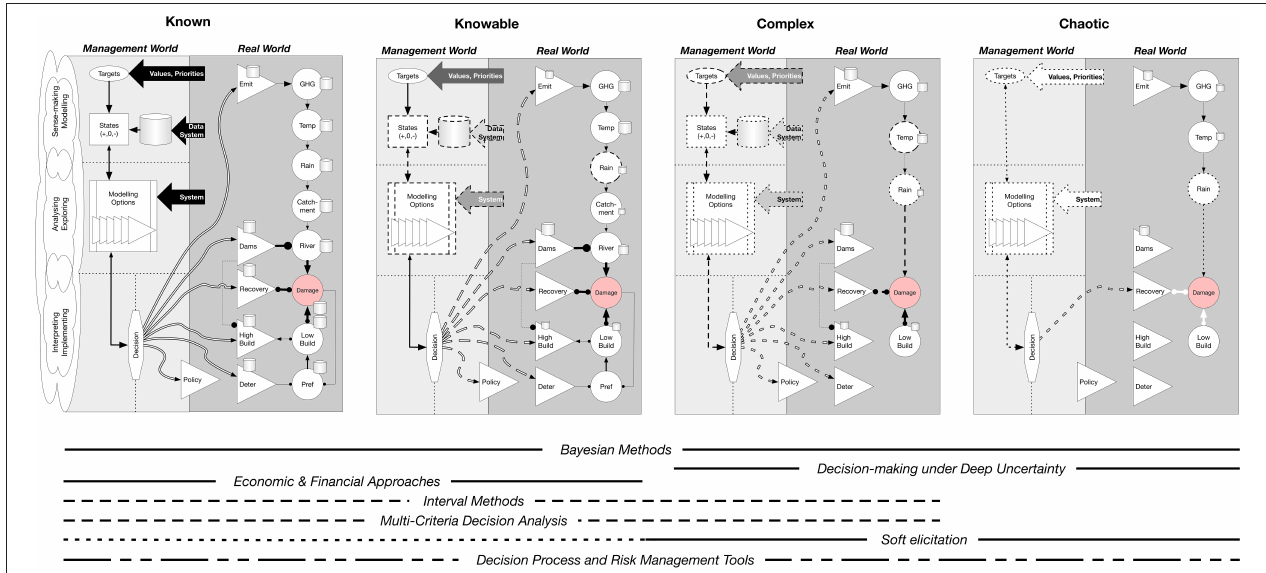
FIGURE 6 | Illustration of how a management system, including the extent of data and models, will differ between Cynefin contexts, following the example in Box 2 . Figure 3 is the Known context on the left. As uncertainty increases according to the Cynefin context (progressive panels toward the right), the ability to evaluate how the risk is changing in the future and to assess the implications of different actions will diminish. These changes are illustrated through change in the uncertainty around each subsystem and the linkages (see Legend in Figure 3 ) or even understanding what subsystems might be present. The interlinked and iterative processes between the three phases of a management system are shown in the cloud on the left. Text in the symbols are summaries of the text from Figure 3 . The application of different approaches to decision analysis (see Section Approaches to Decision Analysis) applicable to the four Cynefin contexts are shown at bottom (solid line = broad application, dashed line = specific methods applicable, dotted line = applicable in some aspects such as in sense-making, double-dash-long-dash line = general useful).